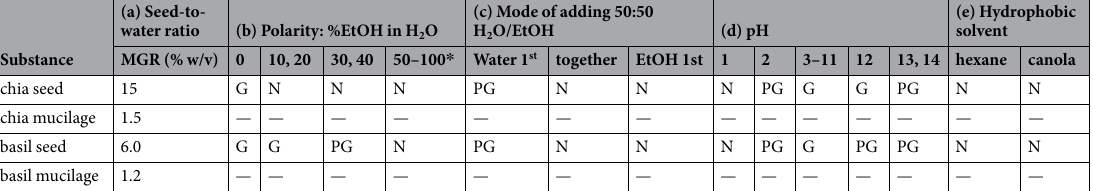
Table 1. The effects of various gelation parameters on gelation of chia and basil seeds. G = gel; PG = partial gel; N = no gel; MGR = minimum gelation ratio; EtOH = ethanol; * 50, 60, 70, 80, 90,